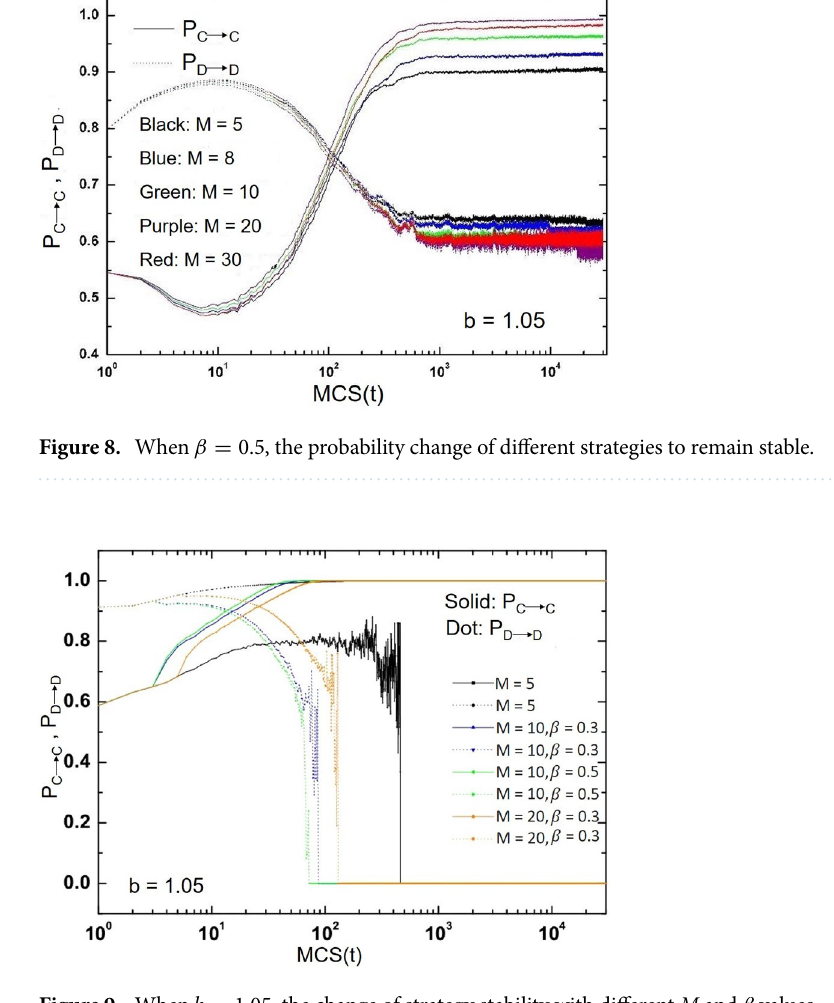
Figure 9. When b = 1.05 , the change of strategy stability with different M and β